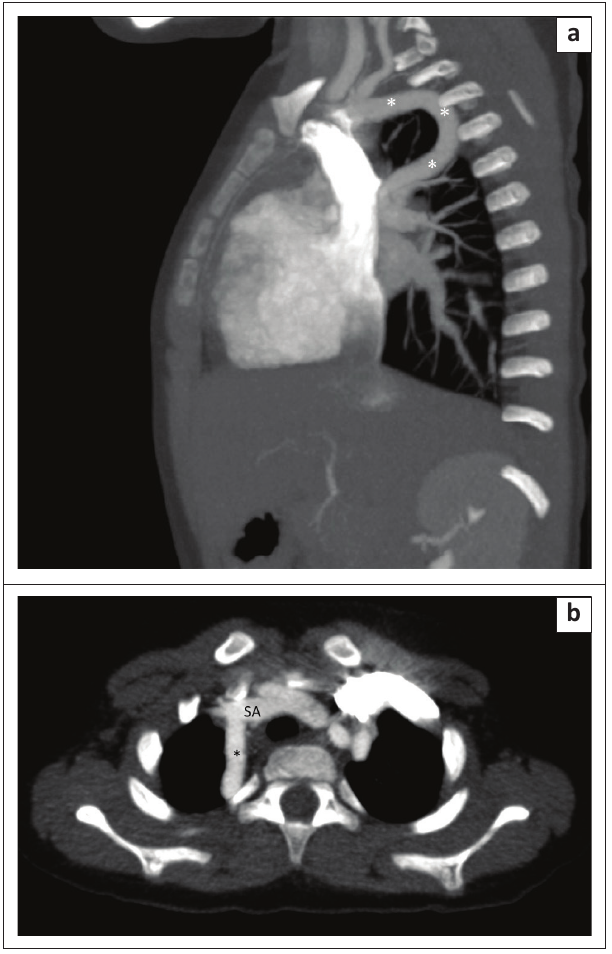
FIGURE 11: Modified Blalock-Taussig (MBT) shunt in a 3-year-old girl. Sagittal MIP (a) depicts the MBT shunt (white asterisks) extending from the undersurface of the right SCA to the ipsilateral pulmonary artery. Axial thick-section MIP (b) shows MBT shunt (black asterisk) origin from the right SCA.